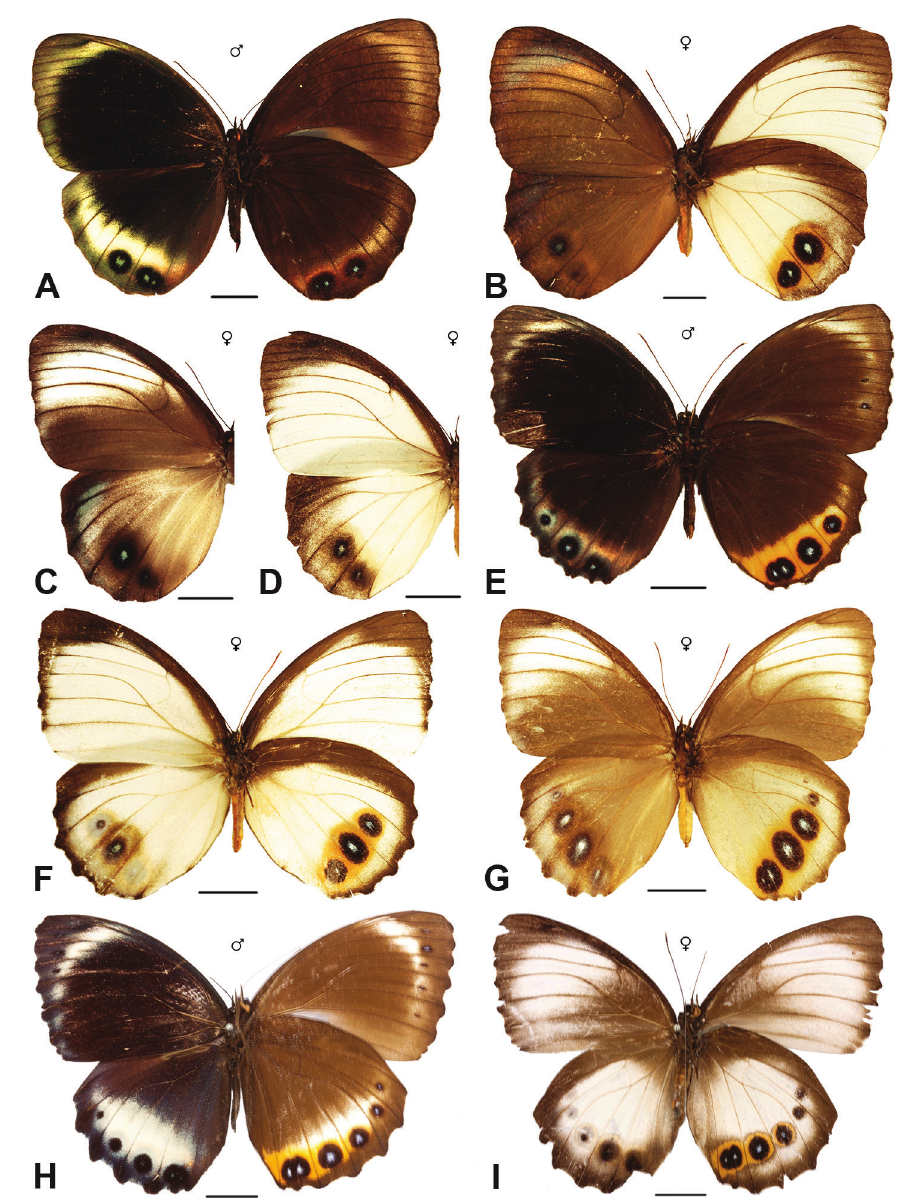
Figure 17. A agondas melanthes ♂ D+V NHM Papua New Guinea: Milne Bay, Woodlark Island B agondas melanthes ♀ D+V NHM Papua New Guinea: Milne Bay, Woodlark Island C agondas melanthes ♀ D NHM Papua New Guinea: Milne Bay, Woodlark Island D agondas melanthes ♀ D NHM Papua New Guinea: Milne Bay, Woodlark Island E agondas aruana ♂ D+V NHM Indonesia: Maluku, Aru F agondas aruana ♀ D+V NHM Indonesia: Maluku, Aru G agondas aruana ♀ D+V NHM Indonesia: Maluku, Aru H ag- ondas ssp. ♂ D+V NHM Indonesia: Maluku, Tanimbar I agondas ssp. ♀ D+V NHM Indonesia: Maluku,